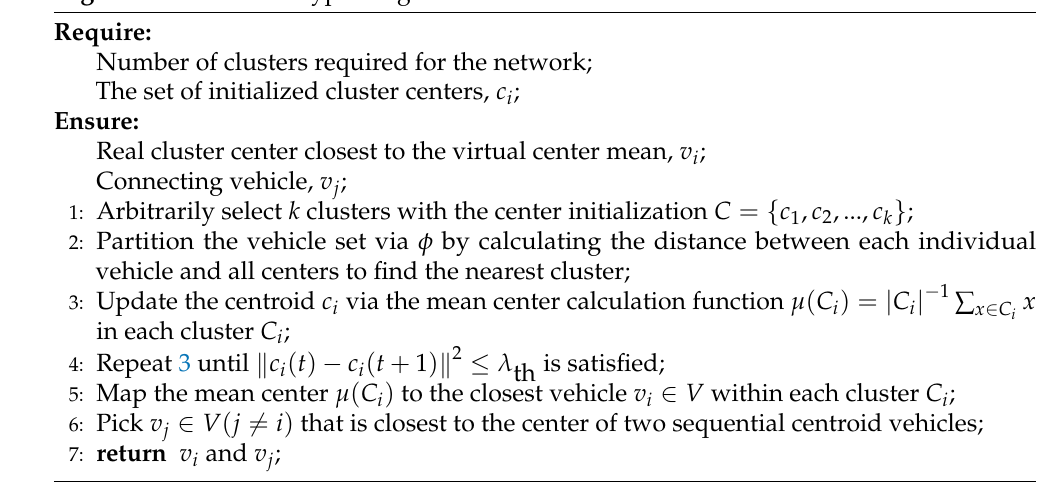
Algorithm 2 K-means-type2 Algorithm for the